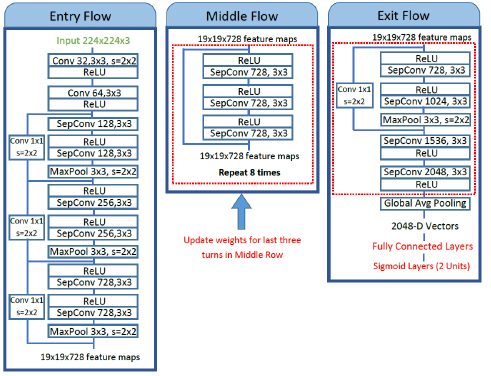
Figure 3. The fine-tuning of proposed method of pre-trained Xception